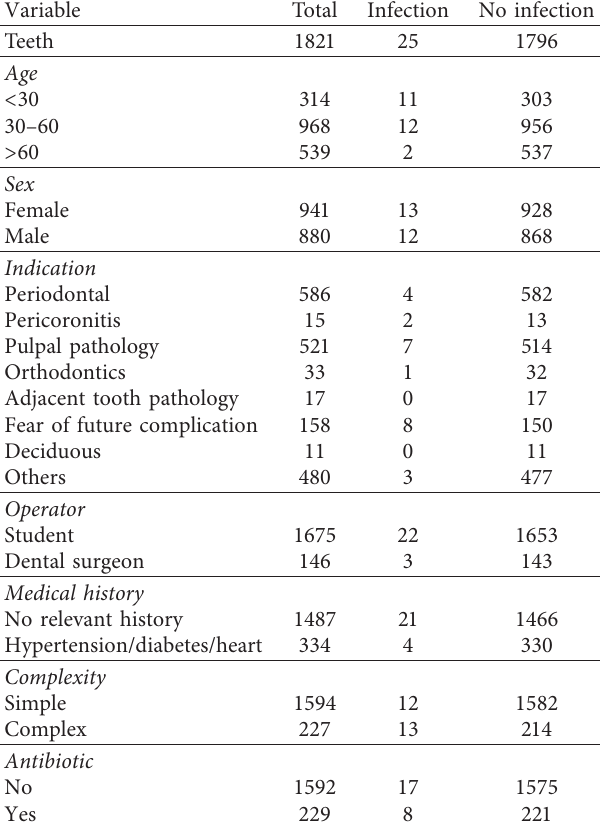
Table 2: Patient and treatment variables showing the number of infection cases reported for each variable.